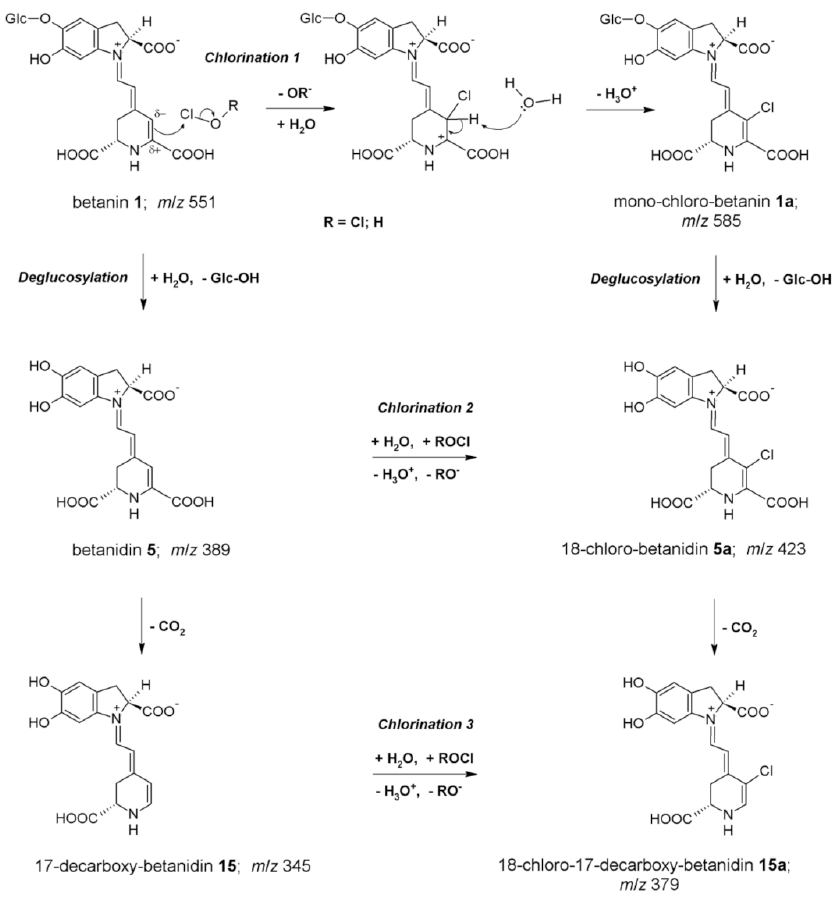
Figure 2. Proposed mechanism of betanin chlorination induced by NaOCl [5] as well as further pathways of deglucosylation and